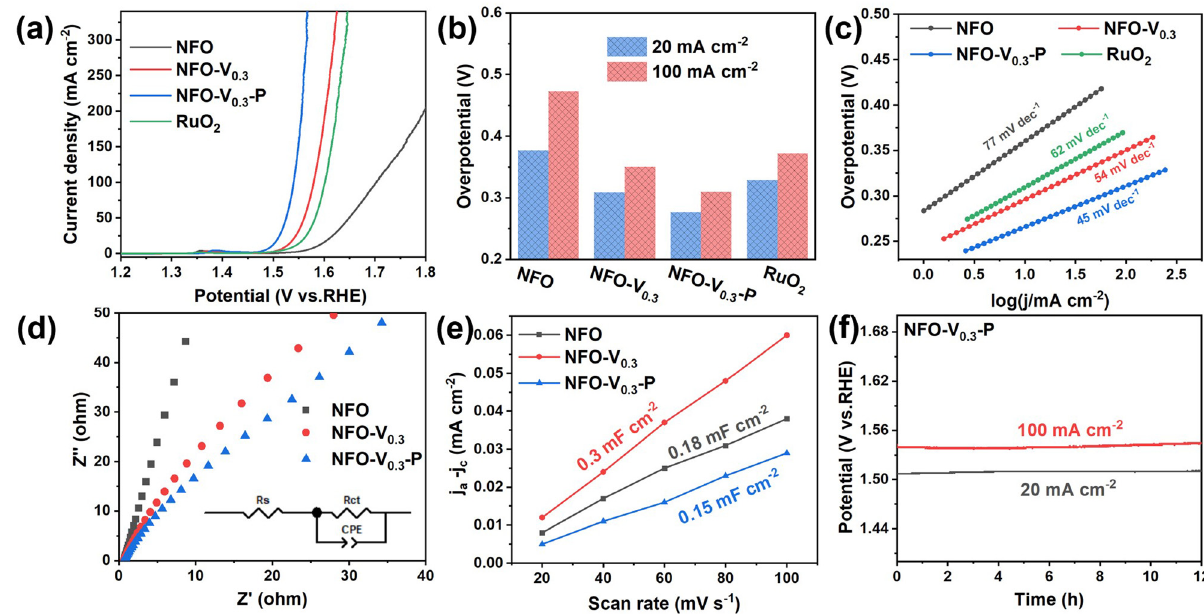
Figure 4: ( a ) iR - corrected LSV curves of NFO, NFO - V 0.3 , NFO - V 0.3 - P, and RuO 2 . ( b ) A comparison of the overpotential values at the current densities of 20 and 100 mA cm − 2 . ( c ) Corresponding Tafel plots of the polarization curves in ( a ) . ( d ) Nyquist plots of NFO, NFO - V 0.3 , NFO - V 0.3 - P. ( e ) The electrochemical C dl of NFO, NFO - V 0.3 , and NFO - V 0.3 - P. ( f ) OER chronopotentiometry measurement of NFO - V 0.3 - P catalyst at the current densities of 20 and 100 mA cm − 2